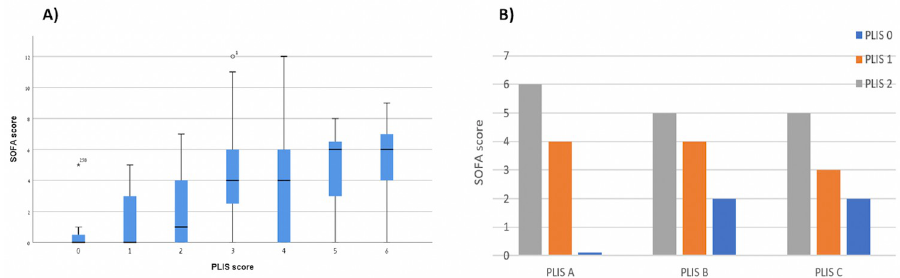
Fig 2. a: Presents the association between the SOFA score and each of the PLIS components: PLIS A (P < 0.001), PLIS B (p = 0.001), and PLIS C (p = 0.001). b: Displays a boxplot diagram of median total PLIS and SOFA scores (interclass correlation 0.63, p <